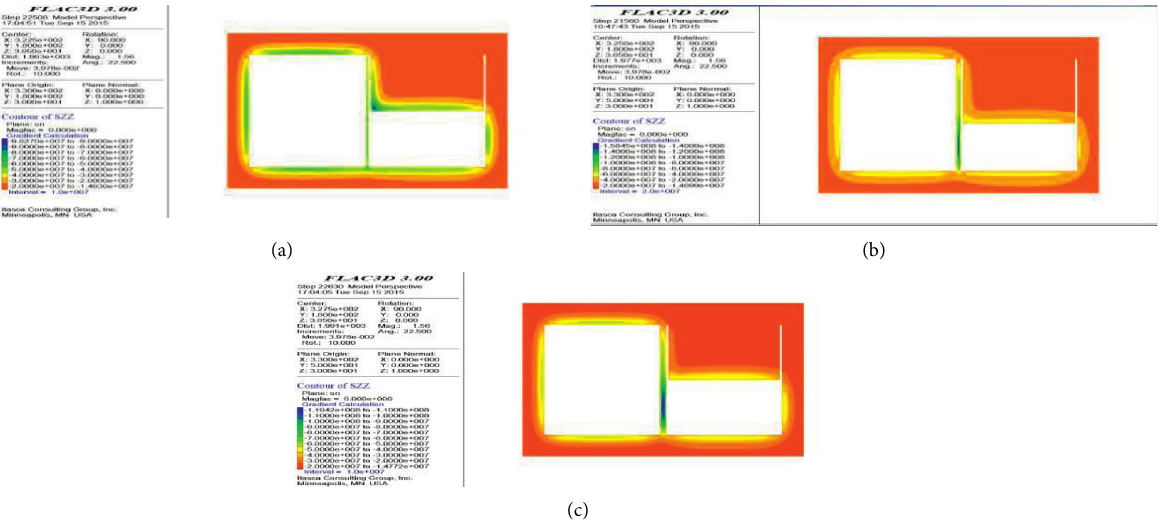
Figure 16: Stress nephogram at 130m stope. (a) Width of pillar is 5m. (b) Width of pillar is 10 m. (c) Width of pillar is